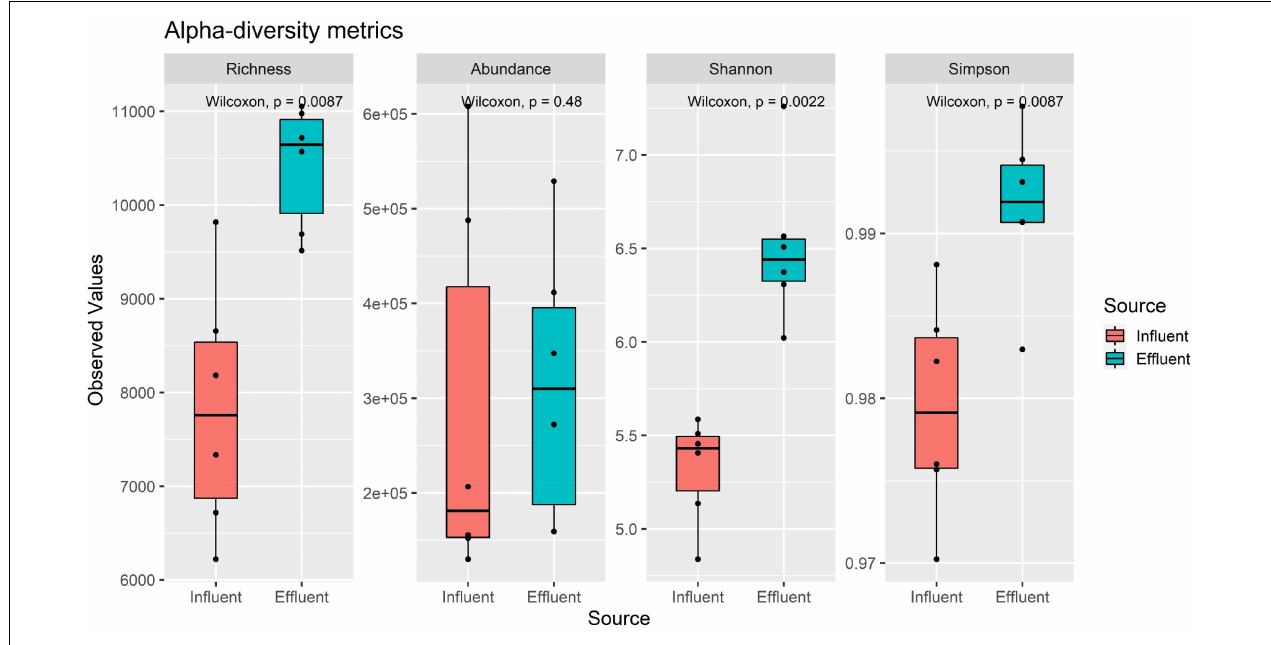
FIGURE 3 | Alpha-diversity metrics of six influent and six effluent